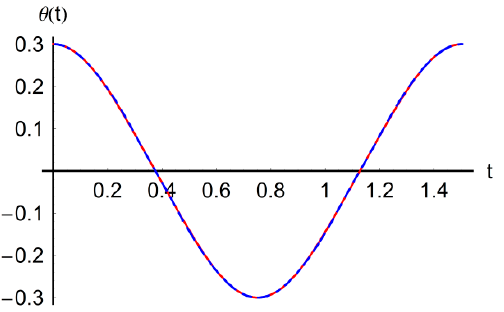
Figure 20. Comparison between the approximate solution (50) and numerical integration results for